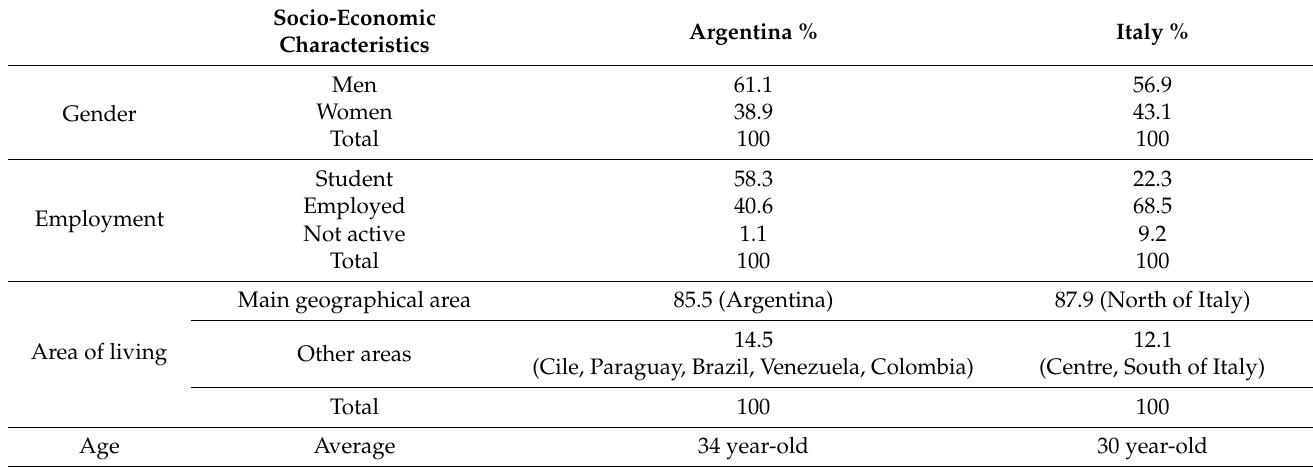
Table 2. Socio-economic characteristics of the